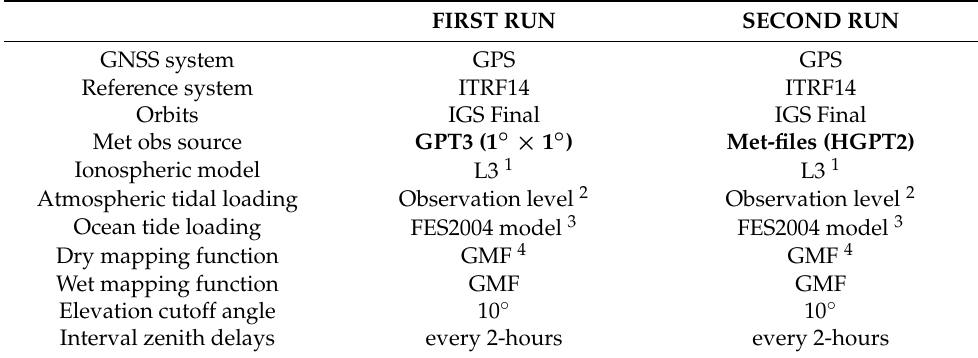
Figure 7. Weight-root-mean-square (WRMS) variation between the two runs (with and without HGPT2) for the station height. Green circles show stations with a positive impact, red circles stations with a negative impact, and black squares stations with no impact. The circle size indicates the magnitude of the impact: negative for values from − 0.8 to − 0.1 mm, and positive values from 0.1 to 0.7 mm. Table 2. Processing main parameters in the GAMIT/GLOBK software. The main difference is the source of the meteorological observation. The first run uses the default options; in the second run, the surface pressure, temperature, and relative humidity at each GNSS station location is provided by the HGPT2 model through met-files. Each run has data from the 70 days selected. The bold option indicates the differences between